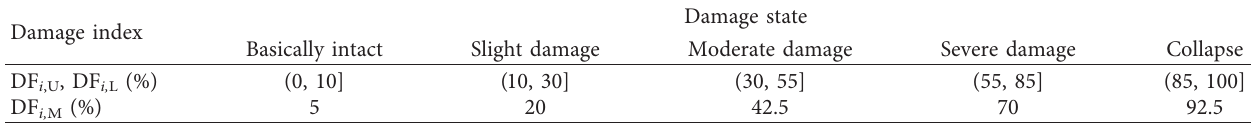
Table 14: Vulnerability index of the structure under the main shock/main aftershock.